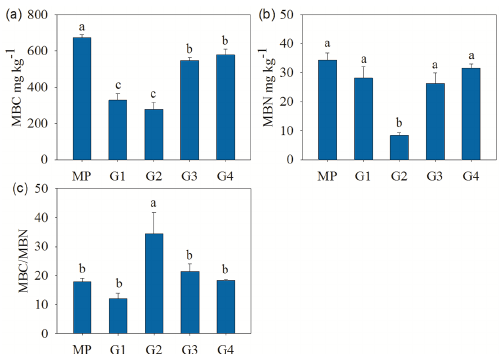
Figure 3. Soil microbial biomass carbon and nitrogen in the Pi- nus and the successive Eucalyptus plantations. MP, G1, G2, G3 and G4 refer to the Pinus plantation and the first, second, third and fourth generation Eucalyptus plantations, respectively. MBC, mi- crobial biomass carbon and MBN, microbial biomass nitrogen. Mi- crobial indicators with the same letter are not significantly different at p